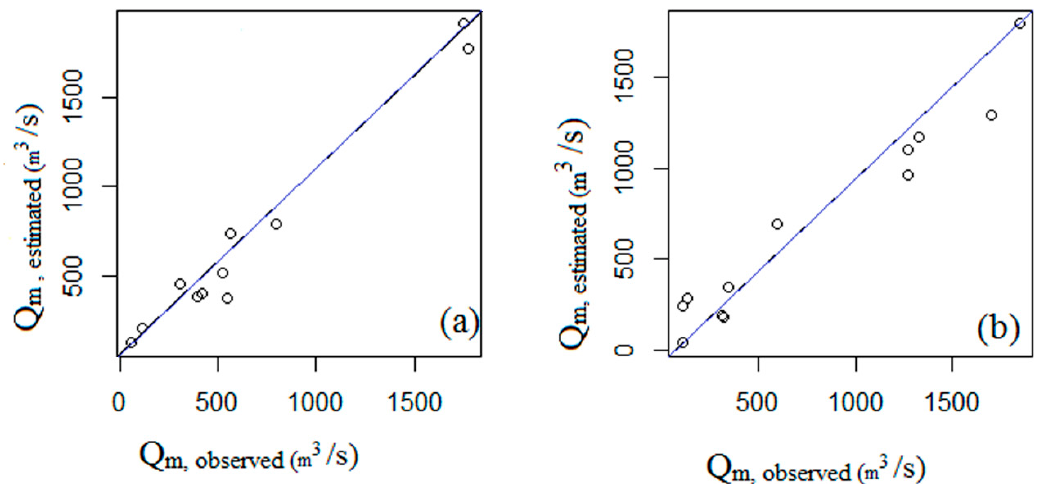
Figure 8. Diagnostic plots of the best regression models: ( a ) for the Oti River Basin and ( b ) for the White Volta and Black Volta basins. The 1:1 line is the plot for reference.